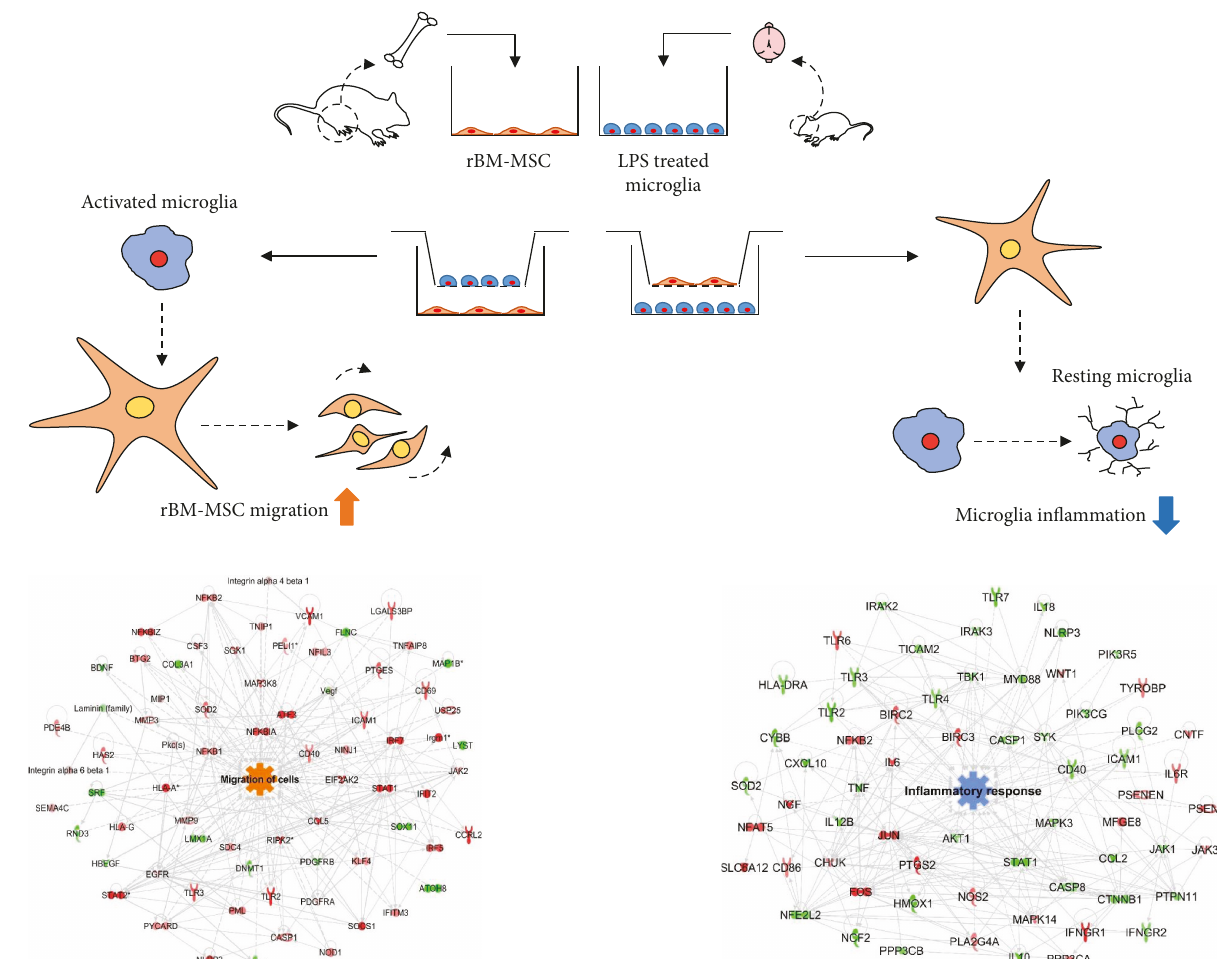
Figure 6: Schematic representation of bidirectional interaction between rat bone marrow-derived mesenchymal stem cells (rBM-MSCs) and activated microglia. Activated microglia increased migration of rBM-MSCs in rBM-MSCs cocultured with LPS-stimulated microglia in an in vitro coculture system. rBM-MSCs decreased the in fl ammatory response of activated microglia in a reverse coculture